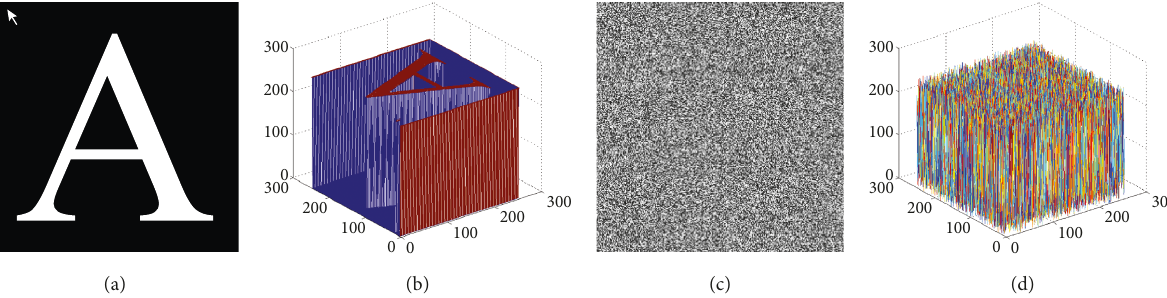
Figure 6: Histogram of binary image and its encrypted image: (a) binary image; (b) histogram of (a); (c) encrypted image; (d) histogram of